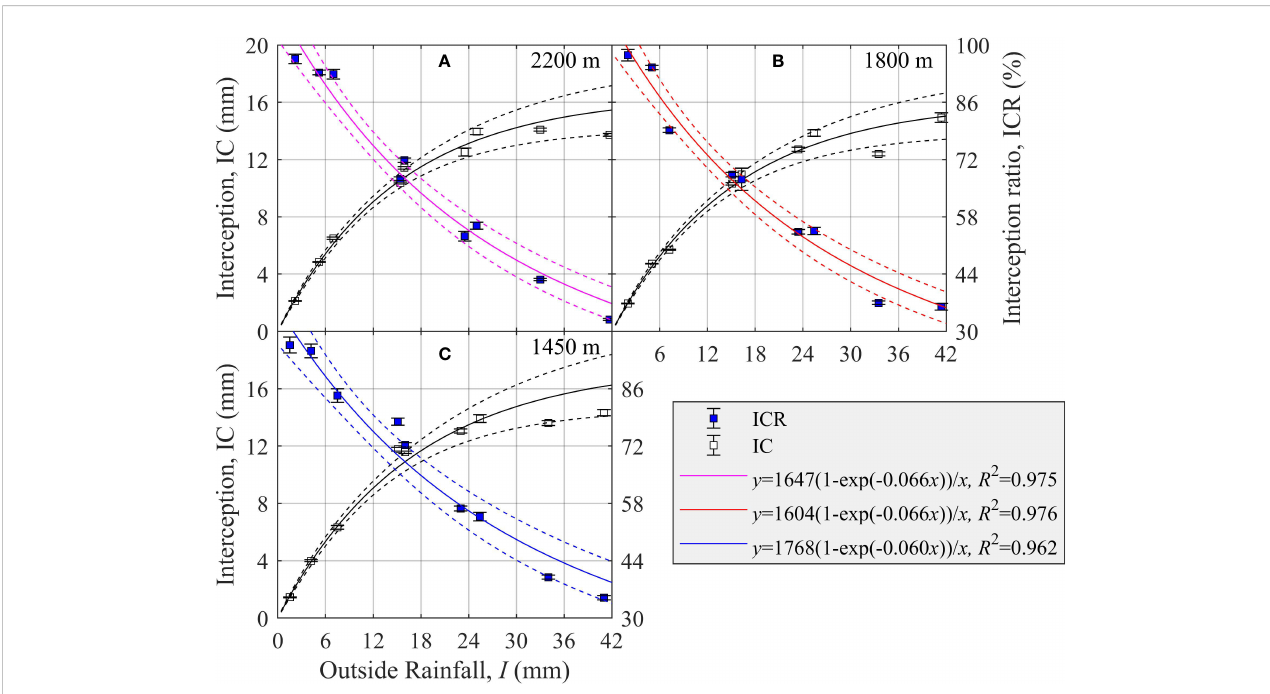
FIGURE 3 Changes in the crown interception (IC, mm) and interception ratio (ICR, %) of Picea schrenkiana as a function of outside rainfall ( I , mm) at three sites on the northern slope of Mount Bogda, Tianshan Range, Xinjiang, China. Error bars indicate the standard error of the mean ( N = 9). Dashed lines are the upper and lower 95% predicted